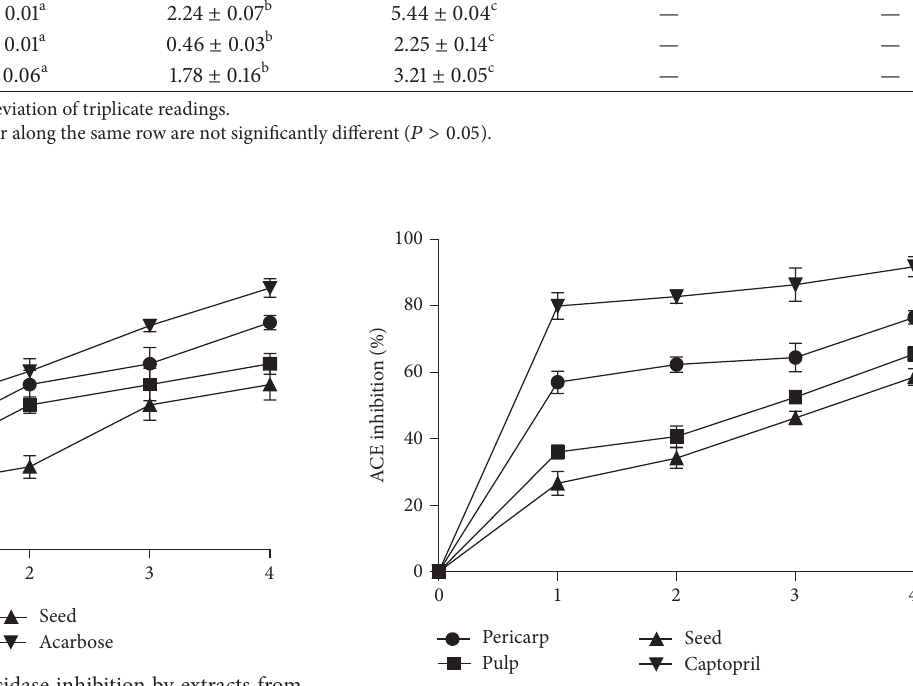
Table 1: EC 50 values for 𝛼 -amylase, 𝛼 -glucosidase, and ACE inhibitory properties and radicals (DPPH and OH) scavenging and Fe 2+ chelating abilities of aqueous extracts of different parts of Soursop fruit (mg/mL) and standards ( 𝜇 g/mL). Pericarp Pulp Seed Acarbose Captopril 𝛼 -Amylase